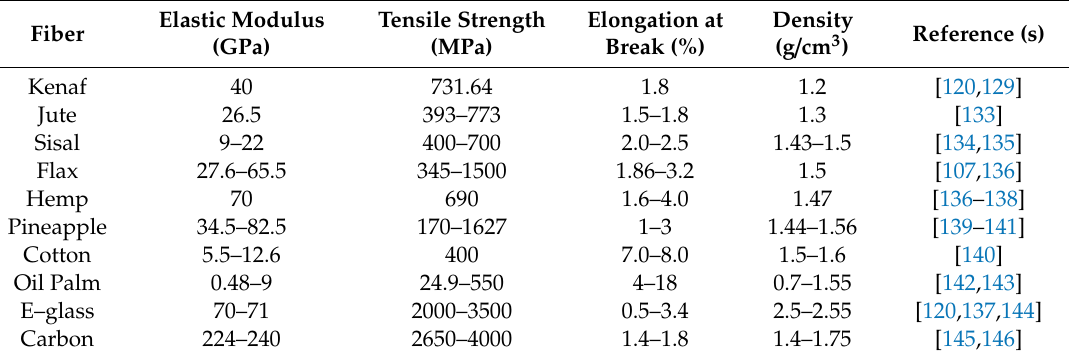
Table 3. Mechanical properties of natural